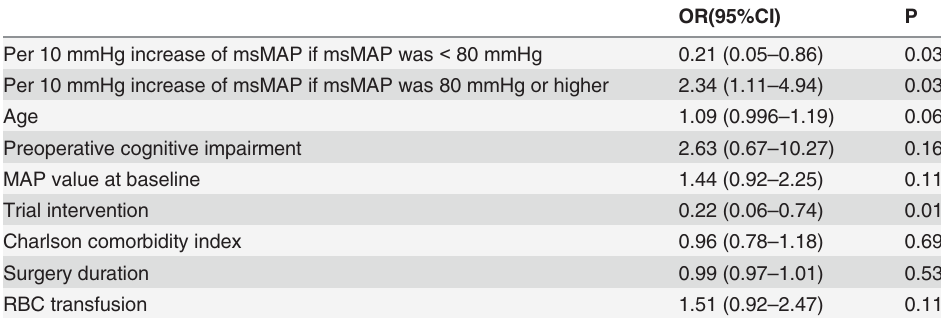
The breakpoints (knots for linear spline) for the logistic regress models were determined using Fig